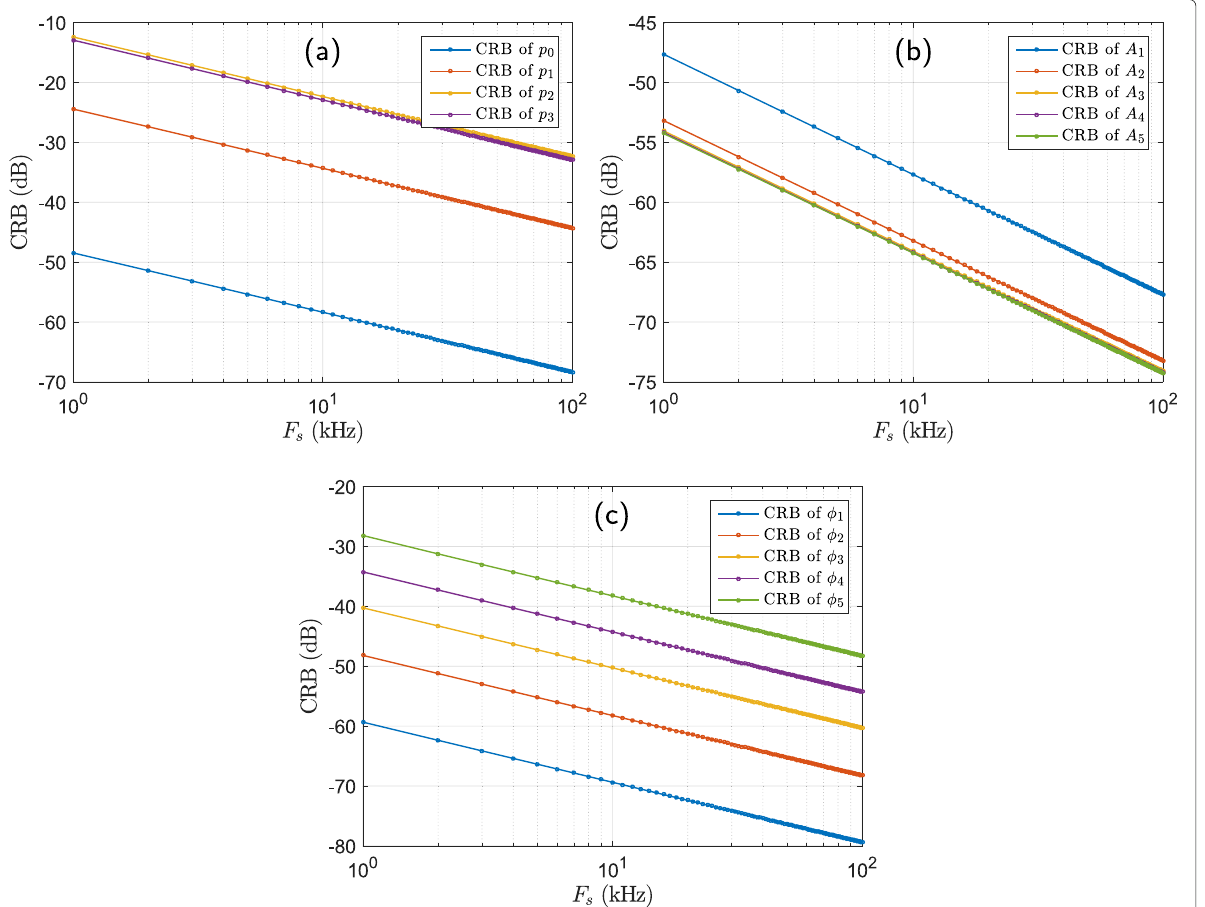
Fig. 8 CRB of the model parameters as a function of the sampling frequency F s (from 1 kHz to 100 kHz) at an SNR of 25 dB. Represented is the CRB of p ( a ), a ( b ), and φ ( c )